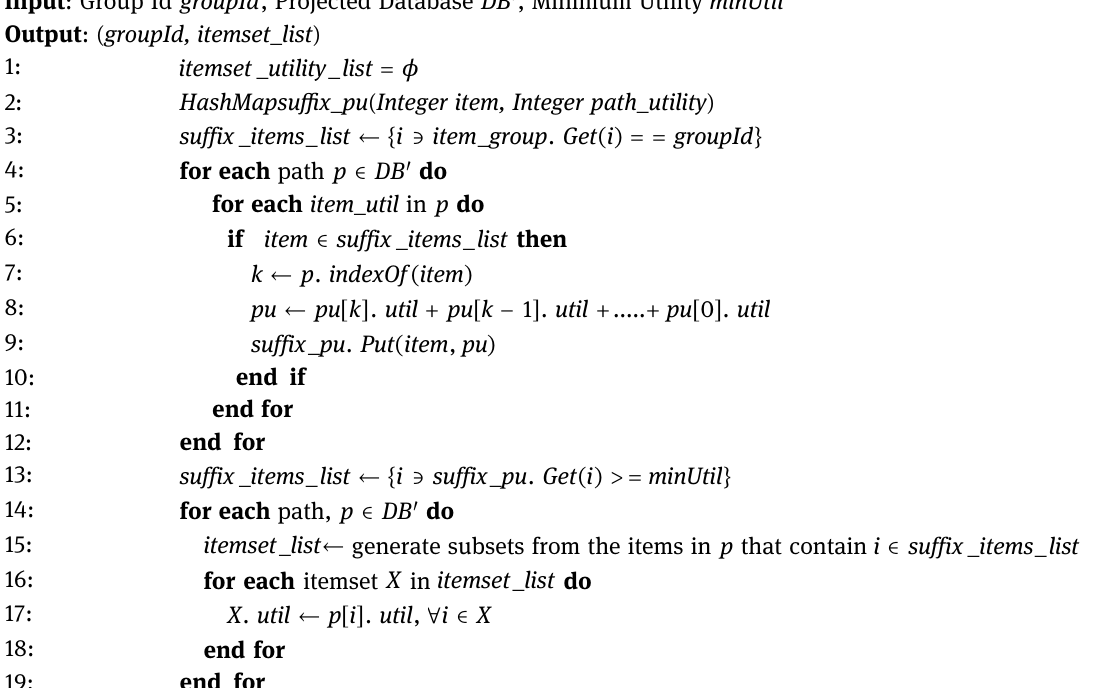
Algorithm 3 Utility computation